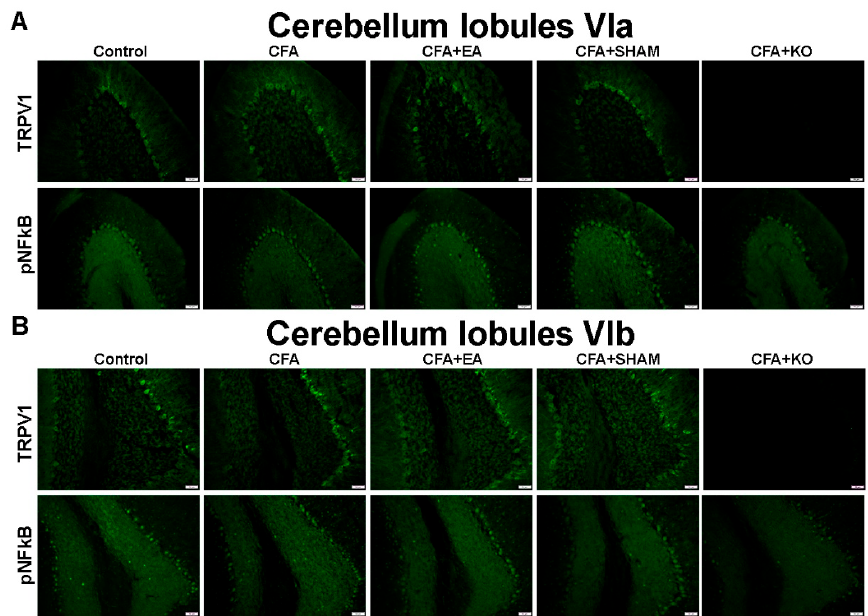
Figure 6 . Immunofluorescence staining of TRPV1 and pNFkB protein expression in the cerebellum lobules VIa and VIb . There are 5 subject groups: control, CFA, CFA + EA, CFA + SHAM, and CFA + KO. ( A ) The effectiveness of EA treatment involves significant reduction of TRPV1 and pNFkB densities in the cerebellum lobule VIa. ( B ) In contrast, there was no nsignificant variance of TRPV1 and pNFkB density in the cerebellum lobule VIb the among five groups of subjects. Scale bar is 50 µ